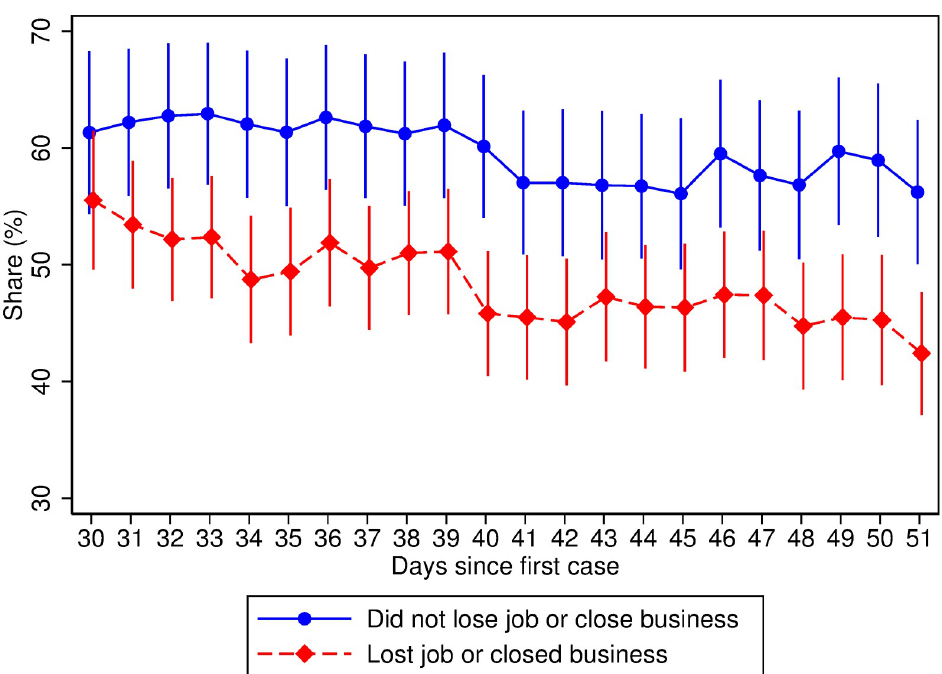
Fig 4. Support for extending lockdown policies declines more among households that lost their livelihoods. Point estimates and 95 percent confidence intervals for the share of respondents supporting extending lockdown policies in relation to the number of days since the first COVID-19 case in the country. Data is weighted using within- and cross- country weights. See the Empirical Methods in the Supplementary Information section for